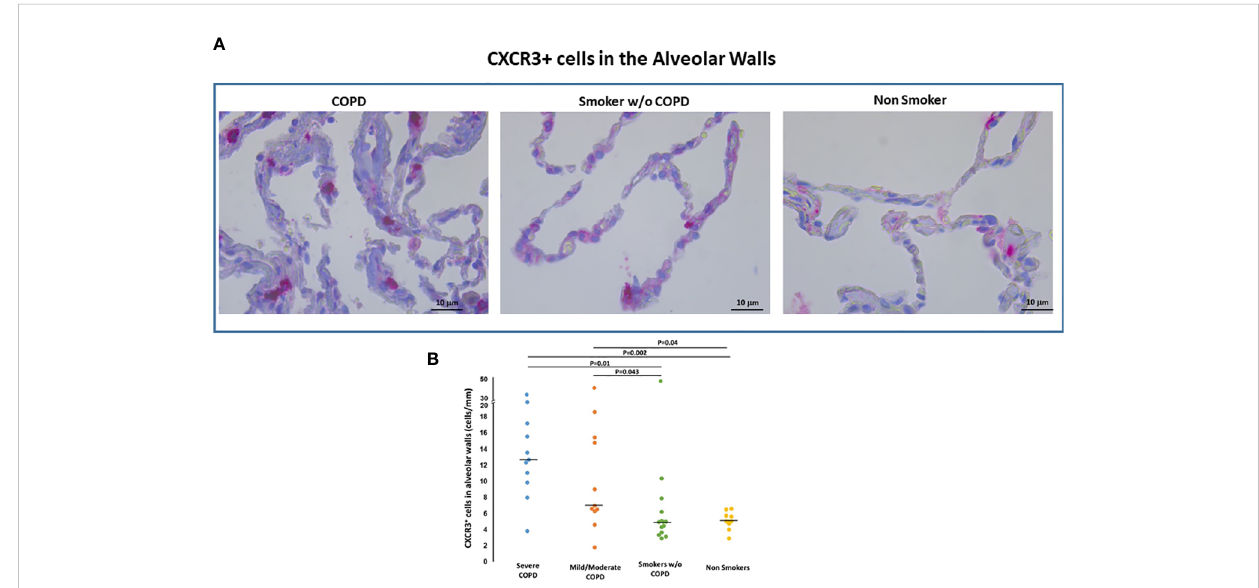
FIGURE 5 CXCR3+ cells in the alveolar walls. (A) Immunohistochemistry of CXCR3+ cells/mm of alveolar wall in smokers with and without COPD and non- smokers. CXCR3 immunoreactivity appears as a diffuse red color at the cytoplasmic level. (B) Number of CXCR3+ cells/mm of alveolar wall in smokers with severe COPD (blue circles), mild/moderate COPD (orange circles), smokers without COPD (green circles) and non-smokers (yellow circles). Horizontal bars represent median values. Overall comparison by Kruskal-Wallis test (p=0.001) with Dunn ’ s multiple comparison test.